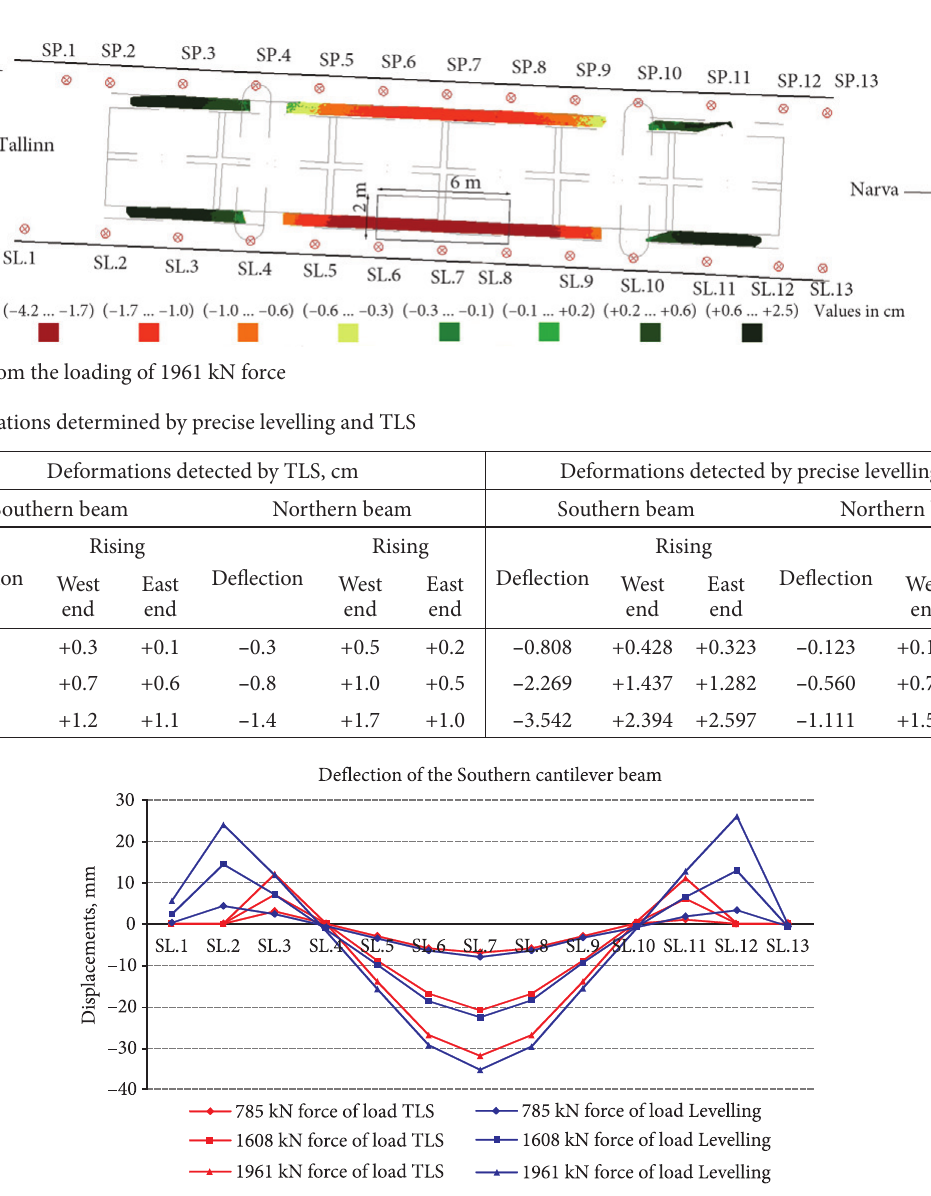
Fig. 10. Comparison of TLS and levelling results of the Southern beam. Note: at the centre of the beam (SL.7) deflection difference between TLS and levelling is under 785 kN + 0.108 cm; under 1608 kN + 0.169 cm; under 1961 kN +0.342